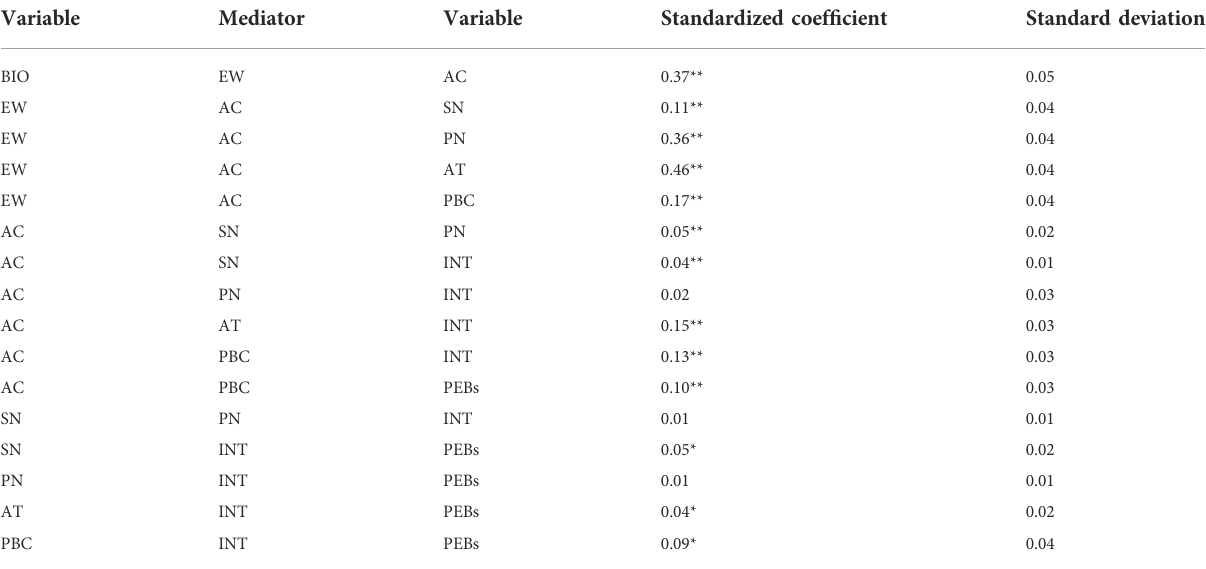
TABLE 5 Results of mediation